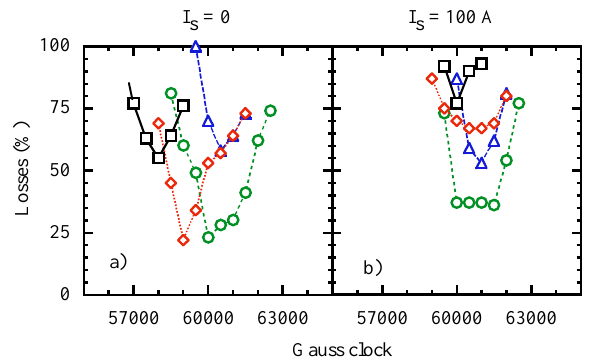
FIG. 5. (Color) Losses going through transition as a function of the time at which the phase of the rf is flipped, and machine field (cid:66) . Here squares, diamonds, circles and triangles refer to D (cid:114) (cid:173) (cid:52)(cid:46)(cid:54) , 1.5, 2 (cid:49)(cid:46)(cid:53) , 2 (cid:52)(cid:46)(cid:54) mm, respectively. (a) (cid:73) (cid:72)(cid:115) (cid:173) (cid:48) , (b) (cid:73) (cid:72)(cid:115) (cid:173) (cid:49)(cid:48)(cid:48)